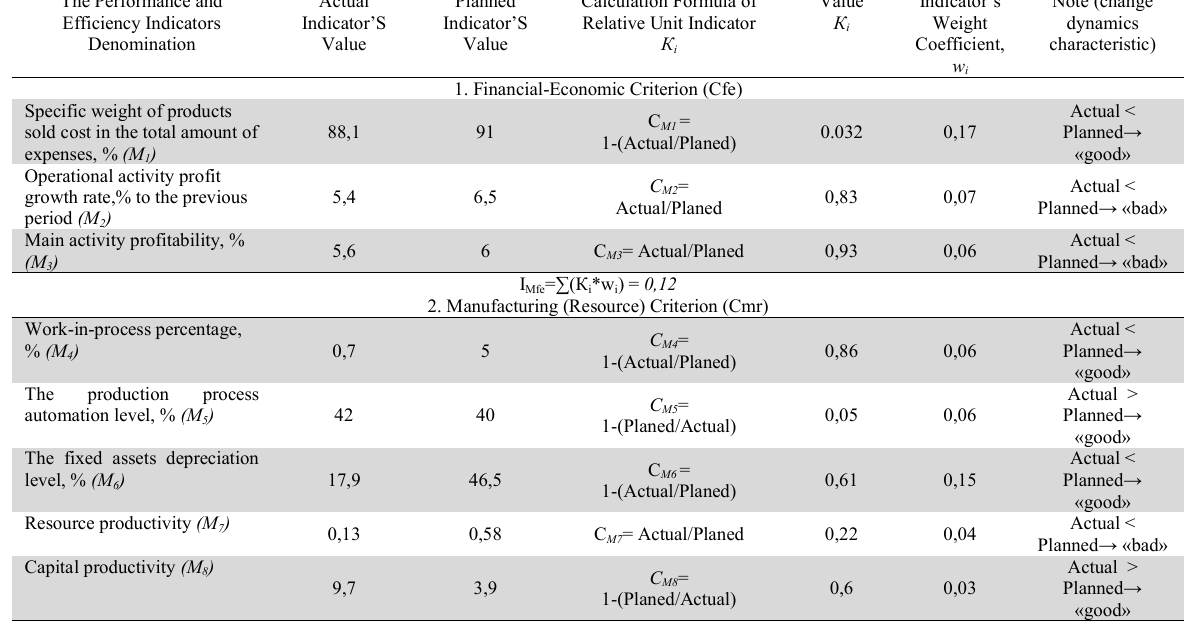
Determination of performance and efficiency indicators of manufacturing business-processes execution of a building company (M) The Performance and Efficiency Indicators